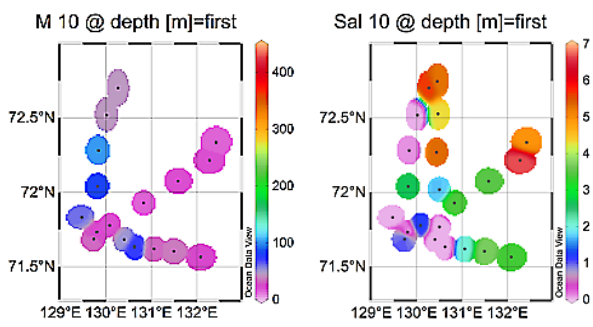
Fig. 5. Surface methane concentrations and salinities in the greater estuary for 2010. For stations see Fig. 1b.